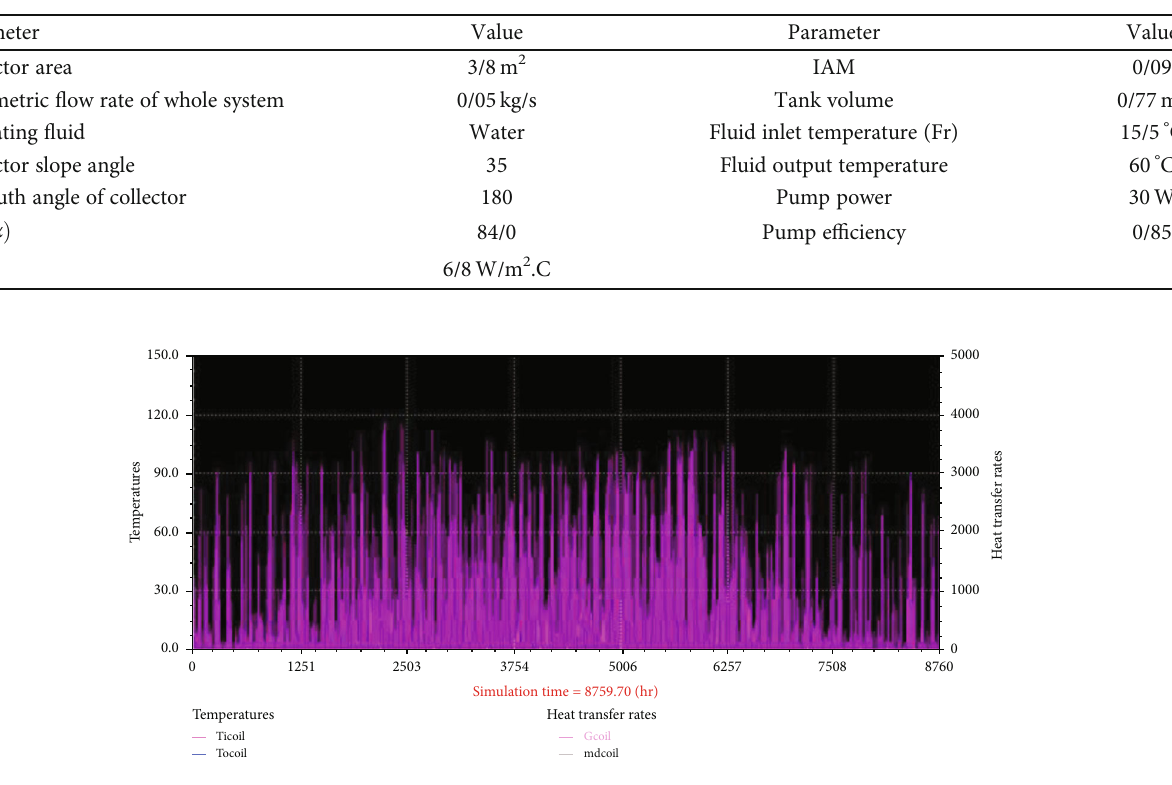
Table 2: Speci fi cations of the components of solar water heater system.